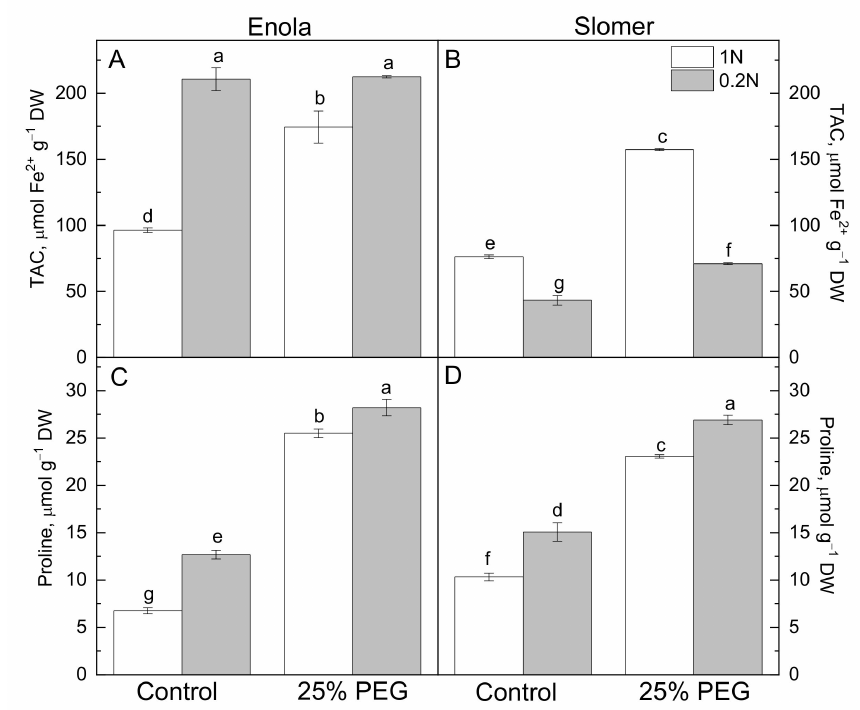
Figure 4. Total antioxidant capacity (TAC) ( A , B ) and proline content ( C , D ) in leaves of two wheat varieties (Enola and Slomer) grown with optimal (1 N) and reduced (0.2 N) nitrogen supply. Different letters represent significant differences at p < 0.05 ( n =